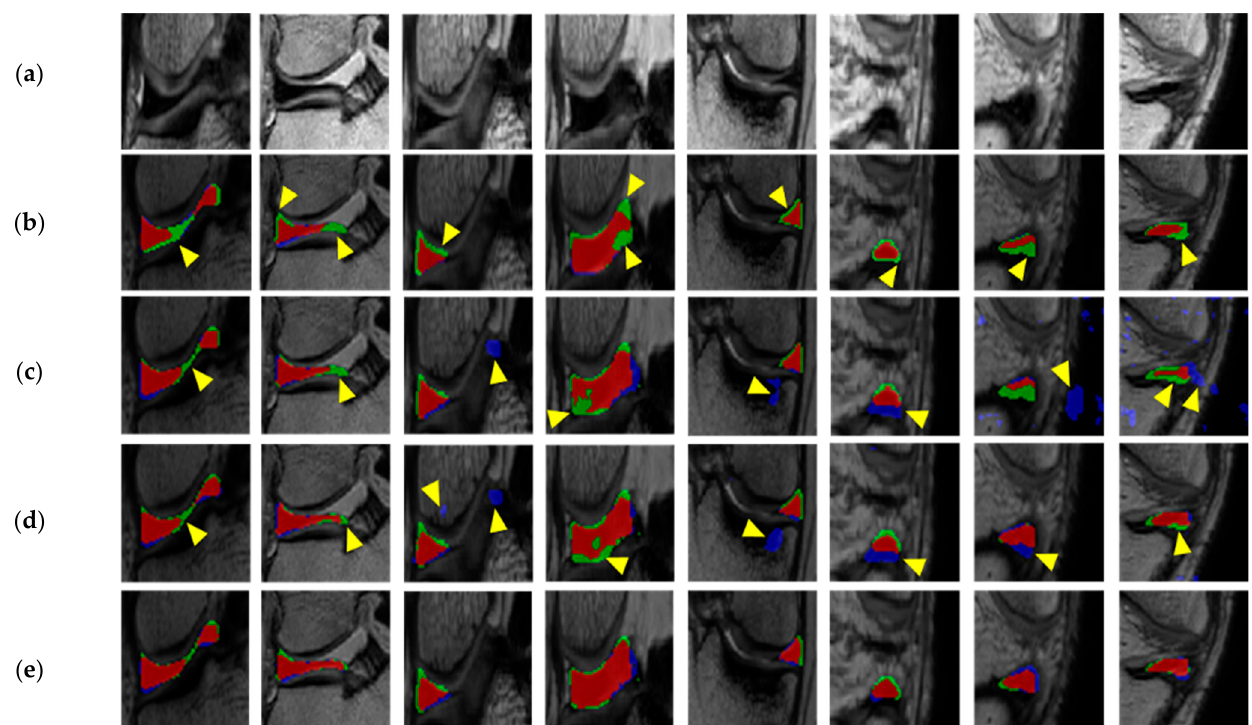
Figure 7. Qualitative evaluation of meniscus segmentation results: ( a ) Test images; ( b ) Results of Method A; ( c ) Results of Method B; ( d ) Results of Method C; ( e ) Results of Method D. (Red: overlay area, Green and Blue: under- and over-segmentation areas, respectively).